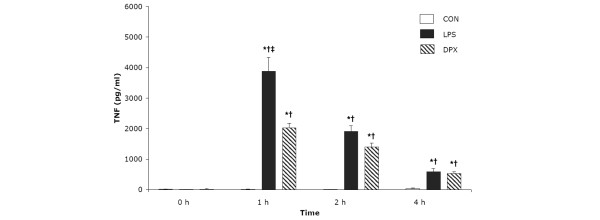
Tumour necrosis factor-α levels. Shown are tumour necrosis factor (TNF)-α levels; measurements were taken one, two and four hours after induction of endotoxaemia. CON, control group; DPX, DPX group (endotoxin plus dopexamine); LPS, LPS group (endotoxin infusion only). *P < 0.05 versus baseline; †P < 0.05 versus CON; ‡P < 0.05 versus DPX.